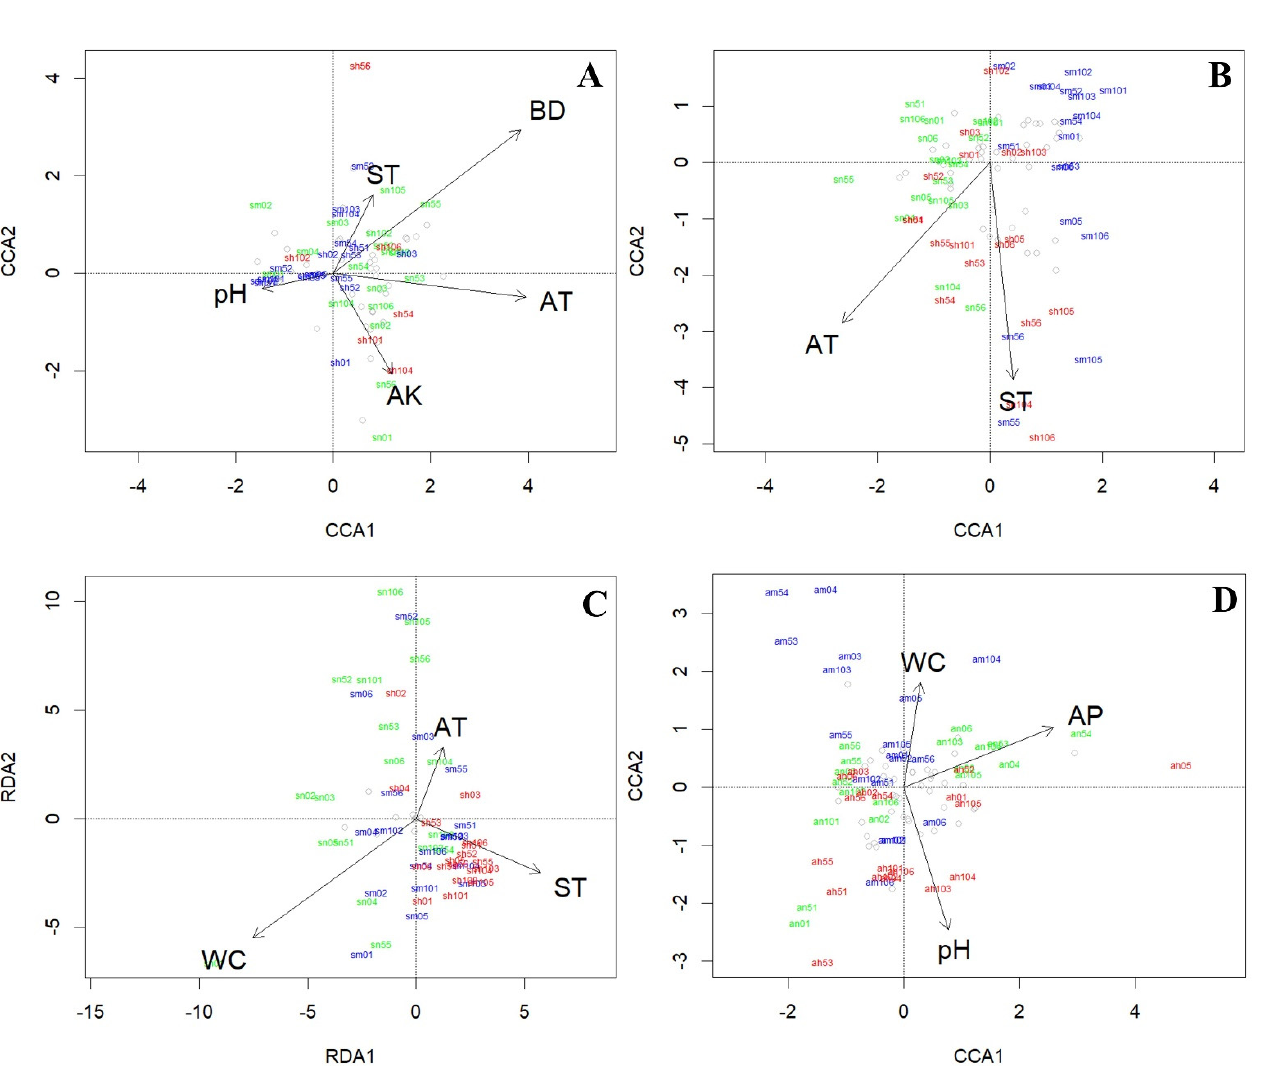
Figure 5. Canonical correspondence analysis (CCA) and redundancy analysis (RDA) ordination plots showing relationships between different soil fauna communities and environmental factors in two seasons. ( A ) soil macrofauna community in summer (CCA); ( B ) microarthropod community in summer (CCA); ( C ) hygrophilous mesofauna community in summer (RDA); ( D ) microarthropod community in autumn (CCA). Arrowhead indicates the direction of increase, and arrow length represents its relative influence. Different colors represent different revetment types (green = NR; blue = MR; red = HR). Grey circles represent different soil animal families. pH = soil pH; SBD = soil bulk density; AN = ammonium nitrogen N; AP = available P; AK = available K; WC = soil water content; AT = air temperature; ST = soil temperature.